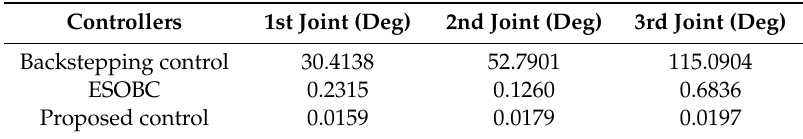
Figure 12. Estimated error results of the extended state observer at 0.5 Hz: ( a ) position error, ( b ) velocity error, and ( c ) lumped uncertainties errors. Table 4. RMSE for the tracking errors of the manipulator at 0.5